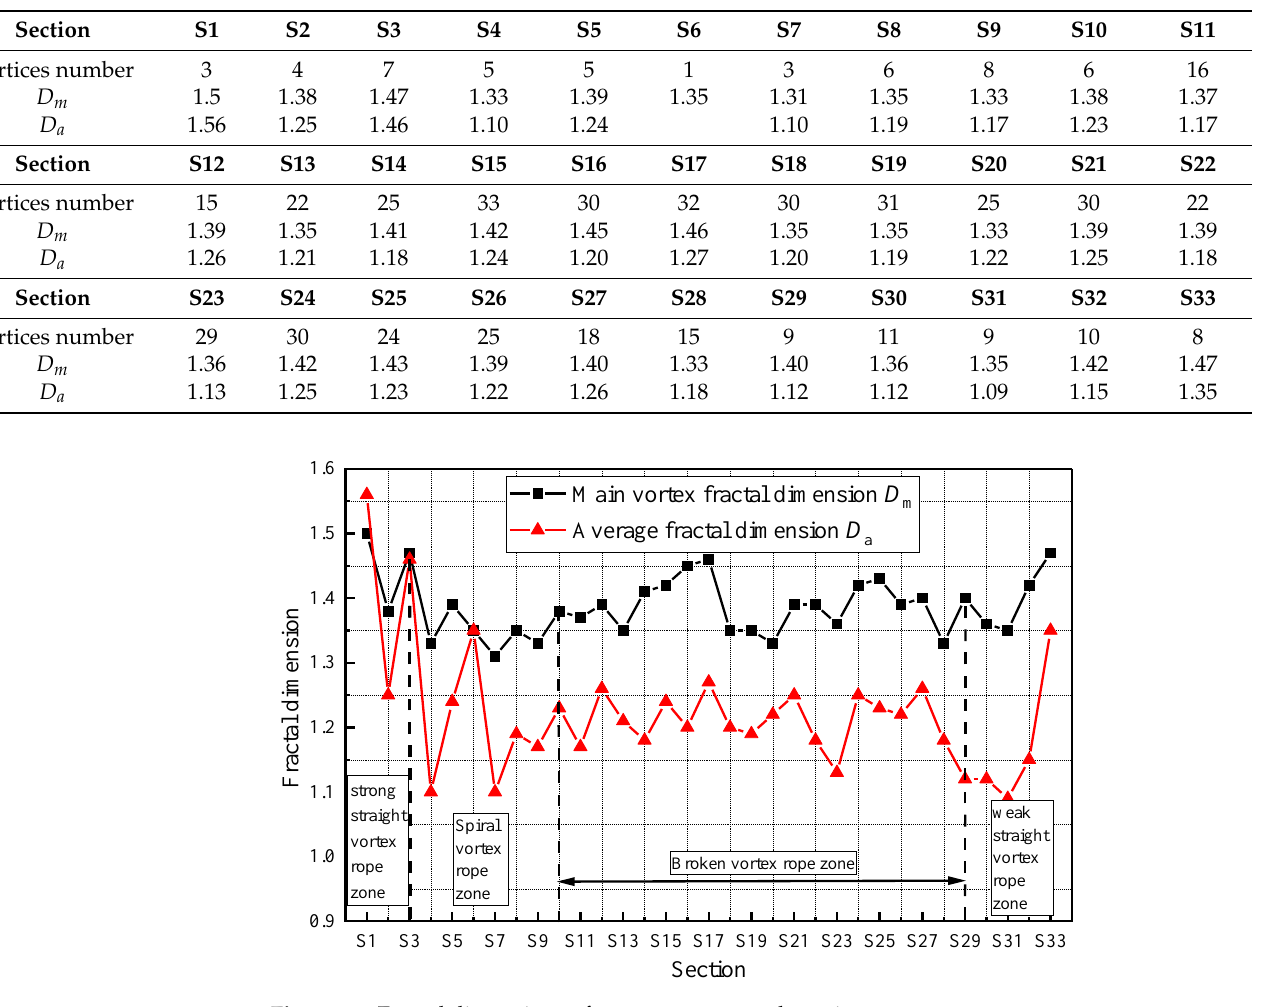
Figure 11. Fractal dimensions of vortex rope on each section. As the vortex rope rotates downstream, its degree of eccentricity increases obviously, the number of secondary vortices also gradually increases, and the overall Da